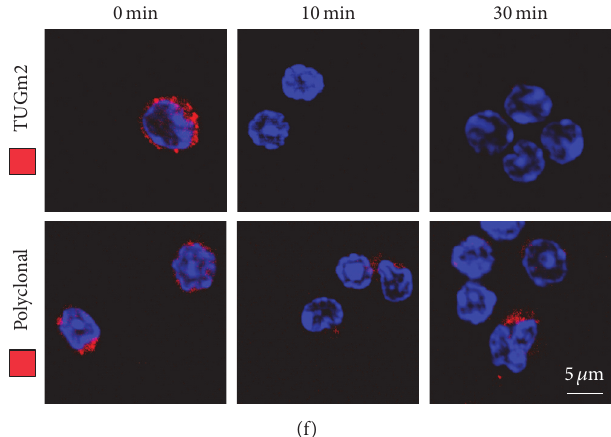
Figure4:The 𝛾 cepitopemaskingbytheconformationalchangeof 𝛾 c.TcellswerestimulatedinthepresenceorabsenceofIL-7for10minutes. (a) 𝛾 c protein level was analyzed by immunoblot. (b) 𝛾 c and IL-7Ra mRNA level were measured by real-time PCR. Blots are representative of four independent experiments. Data are summary of four independent experiments (mean and SEM). (c) LNT cells were isolated from WT and 𝛾 c −/− 𝛾 cTg mice and stimulated with IL-7 or medium. The 𝛾 c (4G3) expression was analyzed 10 minutes after stimulation. Data are summary of three independent experiments (mean and SEM). (d) T cells were immunostained with 4G3, TUGm2, 3E12, and anti- 𝛾 c pAb 10 minutes after IL-7 stimulation. The maximum value of 𝑥 -axis is 250 for all histograms. Histograms are representative of four